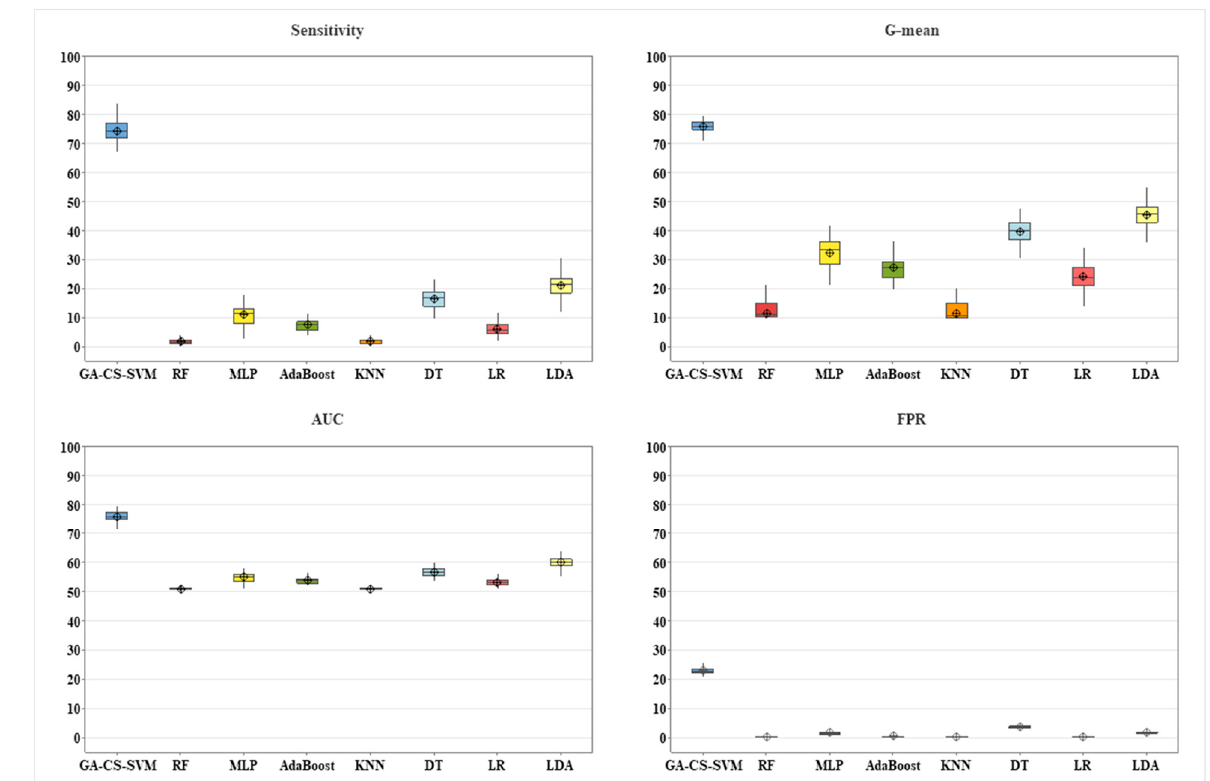
Figure 6. Results for GA-CS-SVM vs. other methods in terms of performance metrics (phase 1).